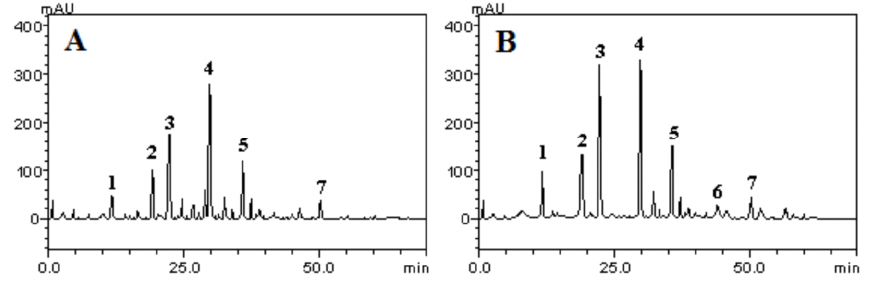
Figure 1. HPLC-DAD chromatograms of aqueous ( A ) and ethanolic ( B ) extracts of the leaves of Raphiodon echinus ( R. echinus ) : Gallic acid (peak 1), chlorogenic acid (peak 2), caffeic acid (peak 3), ellagic acid (peak 4), rutin (peak 5), quercitrin (peak 6) and quercetin (peak 7). Calibration curve for Gallic acid: y = 12574 x + 1307.8 ( r = 0.9999); chlorogenic acid: y = 11953 x + 1278.2 ( r = 0.9995); caffeic acid: y = 11976 x + 1187.0 ( r = 0.9996); ellagic acid: y = 13169 x + 1346.8 ( r = 0.9999); quercitrin: y = 12473 x + 1187.5 ( r = 0.9991); rutin: y = 12814 x + 1189.3 ( r = 0.9999) and quercetin: y = 12537 x + 1375.6 ( r = 0.9994). All Table 1. Schedule of evaluation of oxidation or chelation of Fe 2+ /Fe 3+ by plant extracts. Time Sequence of Addition